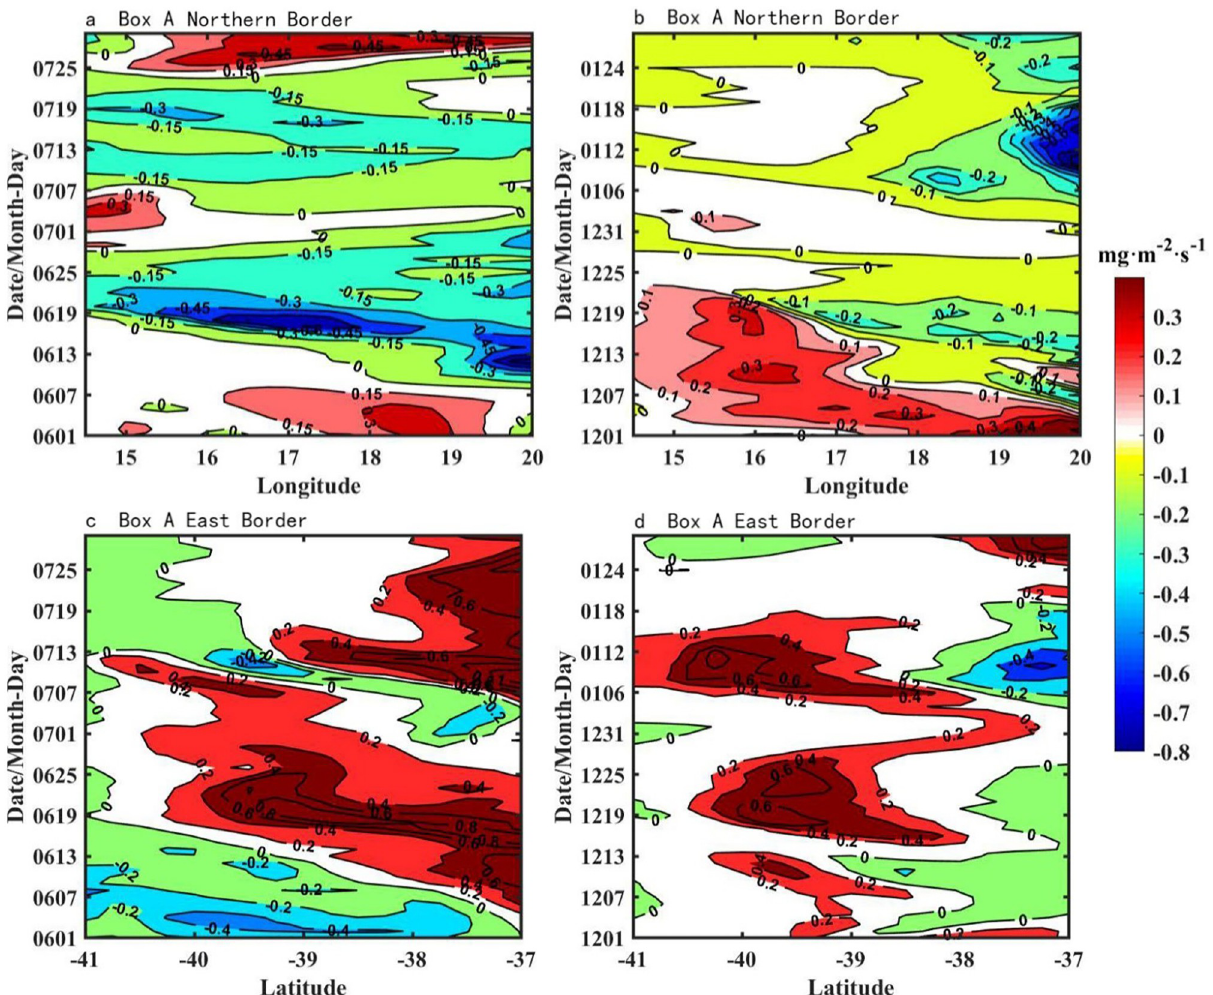
Fig 6. Time series of Chl-a flux in Box A (a) north (c) east boundary from June to July in 2013, (b) north (d) east boundary from December 2013 to January